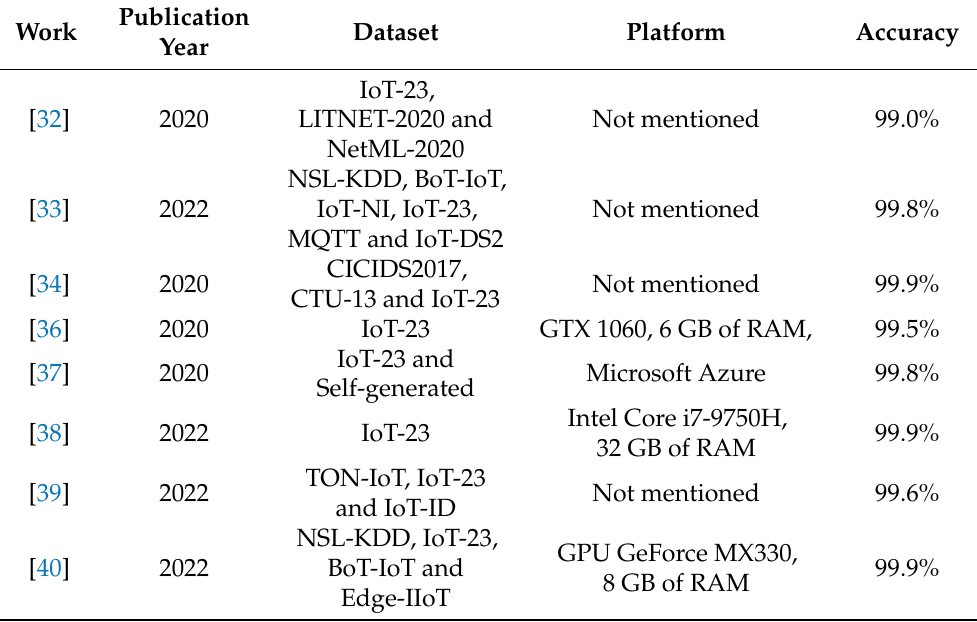
Table 2. Summary of anomaly-based IDS on the IoT-23